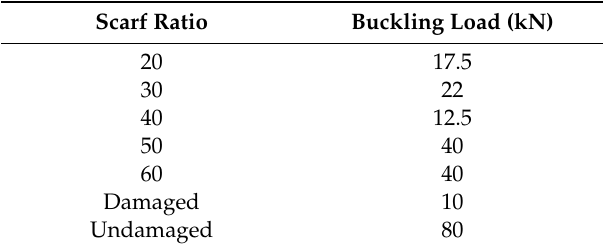
Table 4. Summarized results of global buckling